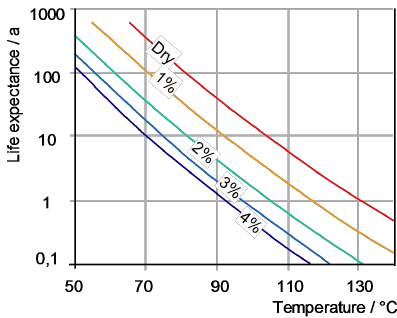
Figure 19. Life expectance of oil impregnated paper depending on temperature and water content